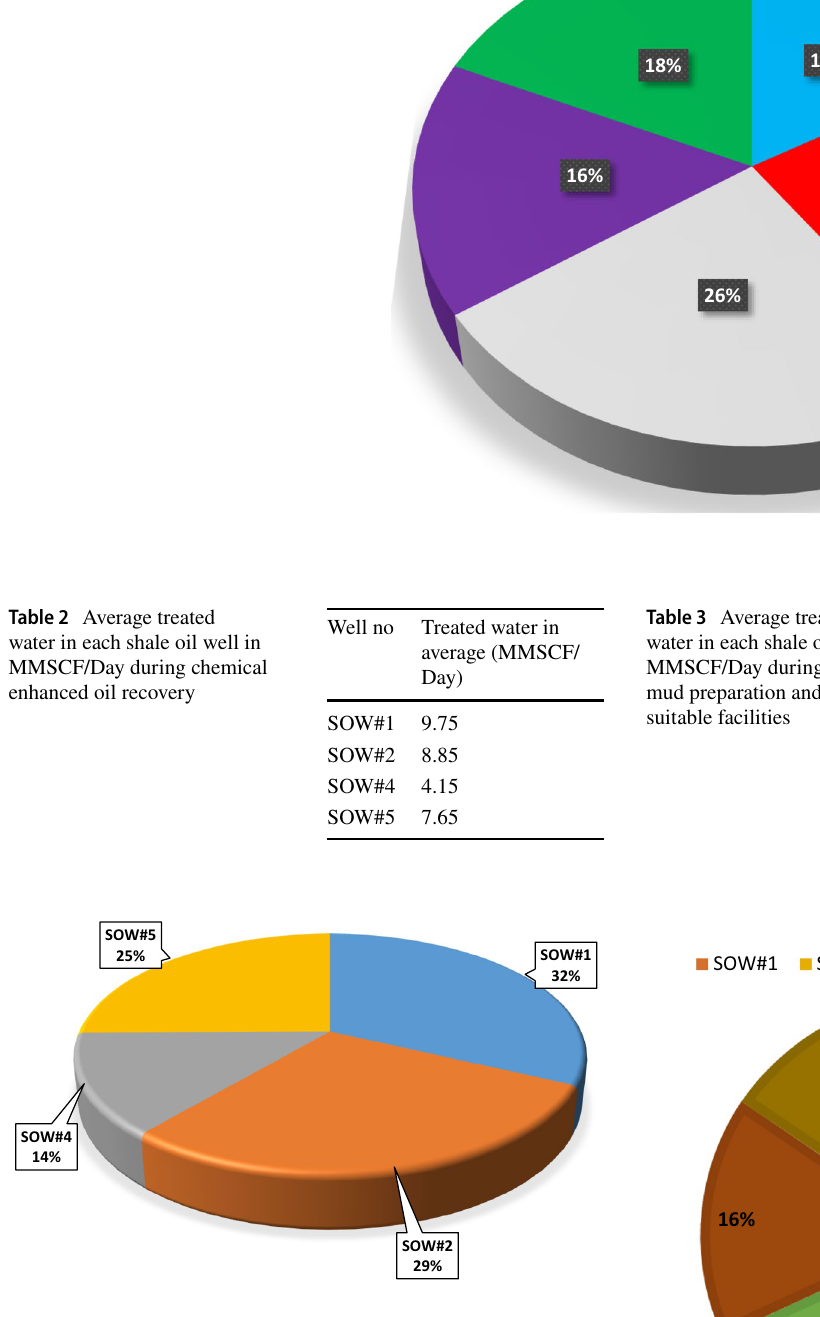
Fig. 2 Treated wastewater for each shale oil well during chemical enhanced oil recovery